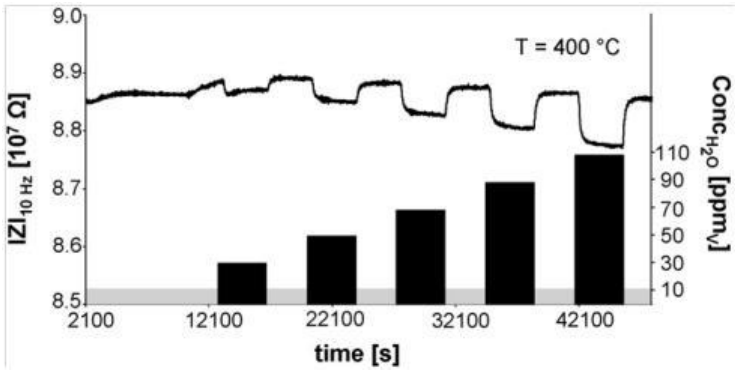
Figure 14. Impedance of H-ZSM-5 type zeolite as a function of water concentration at 400 °C under hydrogen environment, the bar chart is an indication of the water concentration used for the various experiments (right y-axis) (adapted from Reference